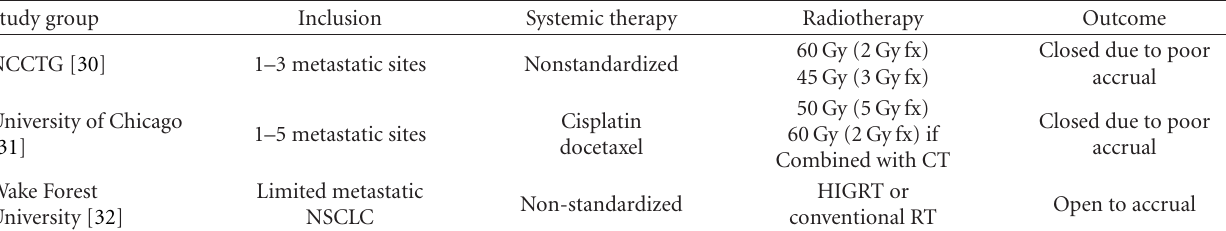
Table 2: Prospective study characteristics for comprehensive treatment of limited metastatic NSCLC with hypofractionated RT. Study